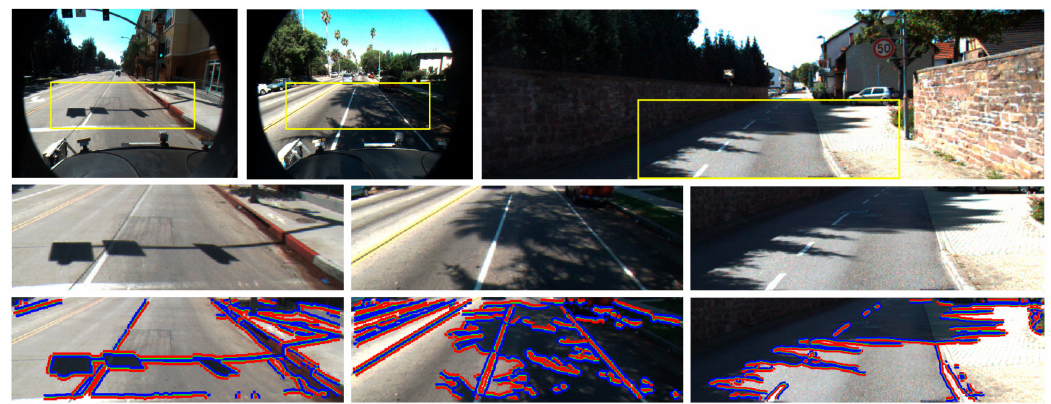
Figure 12. ( Row 1 ) input images; ( Row 2 ) ROI of the input images; ( Row 3 ) ROI overlaid with brighter (red) and darker (blue) regions across strong edges